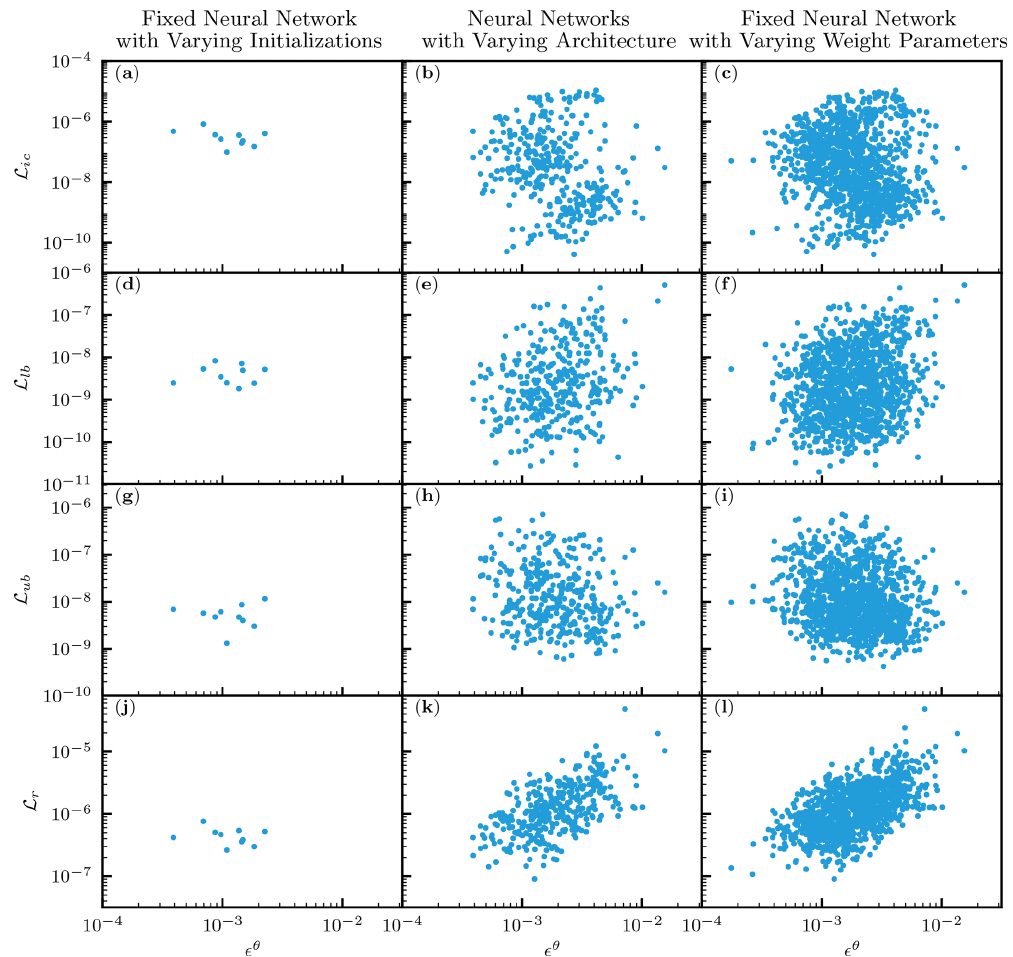
Figure 10. Homogeneous soil. The relationships between loss terms L i and the relative squared error in terms of volumetric water content (cid:15) θ for a fixed neural network (NN) with different NN initializations (left column), NNs with varying architecture (center column), and a fixed NN with varying weight parameters λ i in the loss function (right column). L ic , L lb , L ub , and L r are the loss terms for the initial condition, lower- and upper-boundary conditions, and the residual of the PDE,